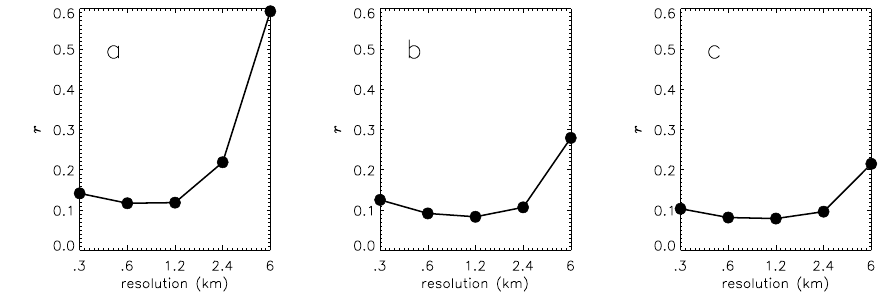
Fig. 7. Statistical parameter r for τ c vs. N a for the native resolution and aggregated scenes from “a”, “b”, and “c” in Fig. 4.